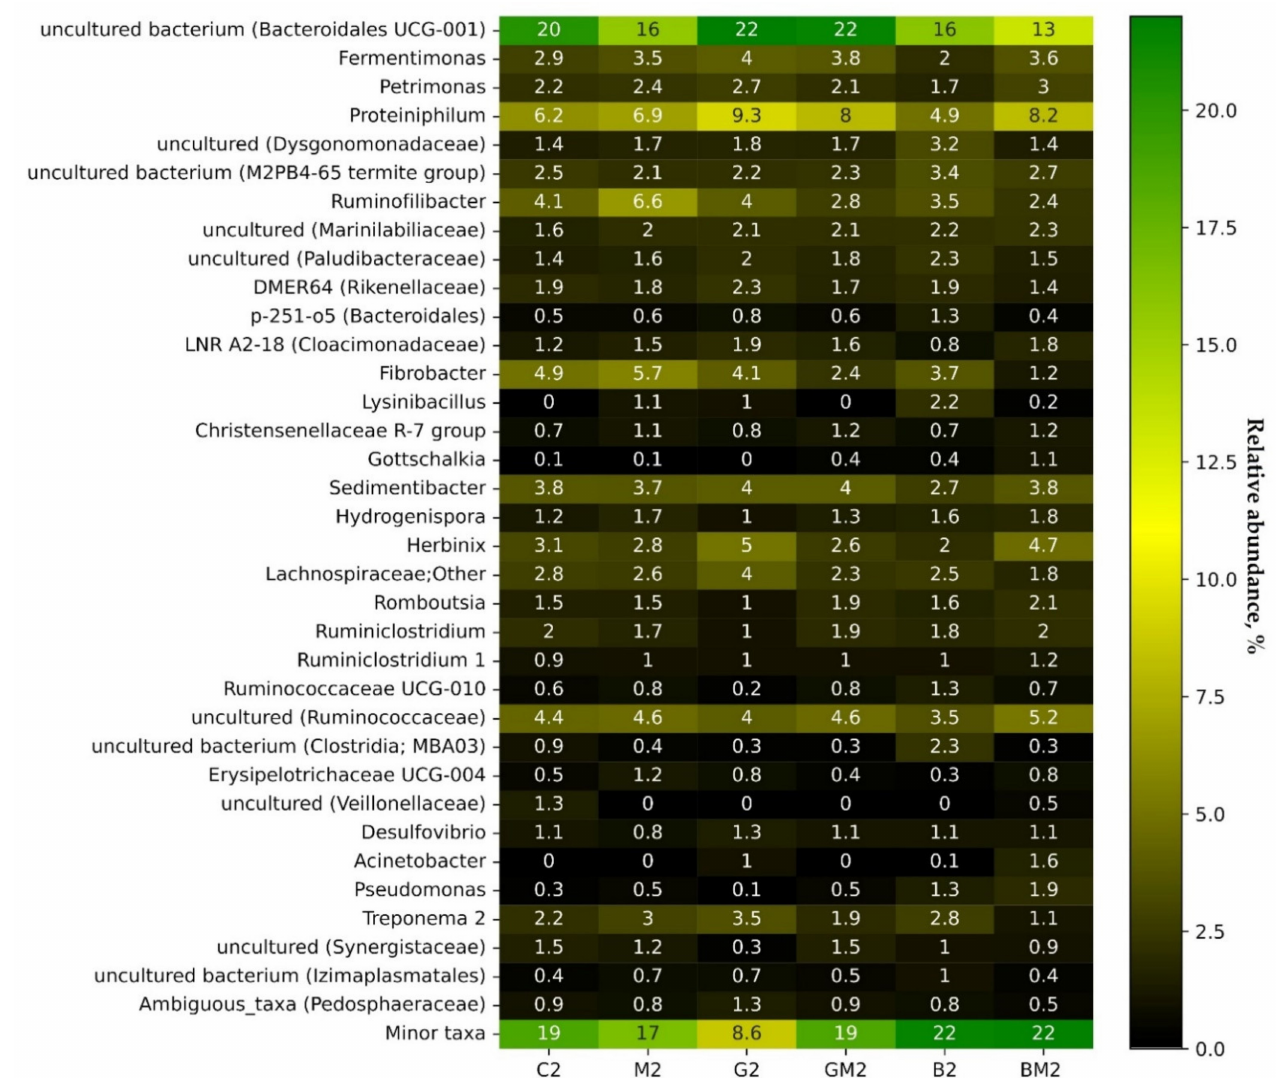
Figure 6. Heatmap demonstrating the relative abundances of bacterial genera in the reactors (sampled on day 6). Only genera comprising at least 1% relative abundance in at least one sample are